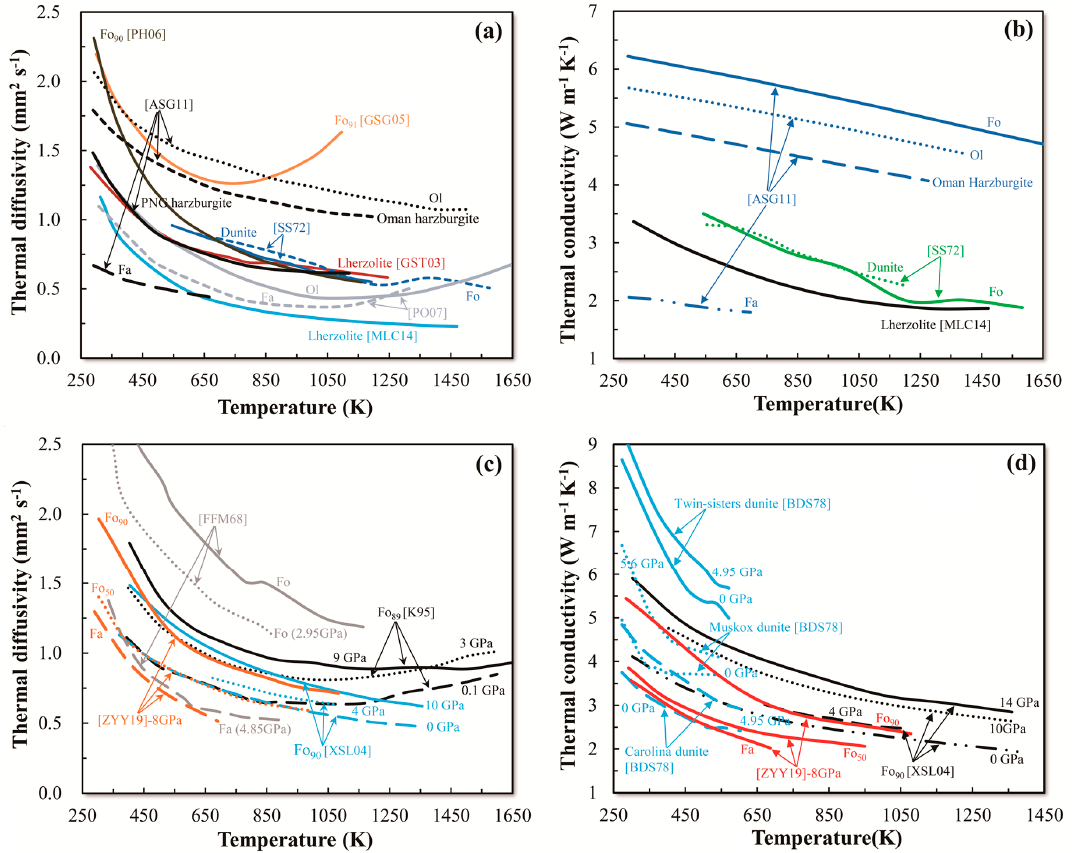
Figure 2. Temperature dependence of D and κ of polycrystalline olivine. ( a ) and ( c ): D . ( b ) and ( d ): κ .